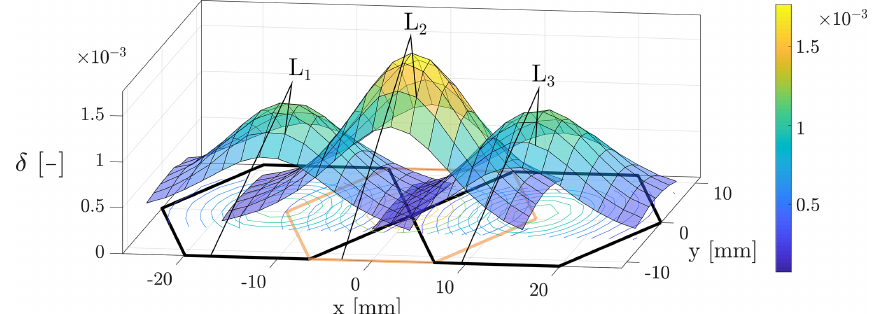
Figure 4. SRM values for L 1 ,L 2 and L 3 and the outlines of the hexagonal coils.